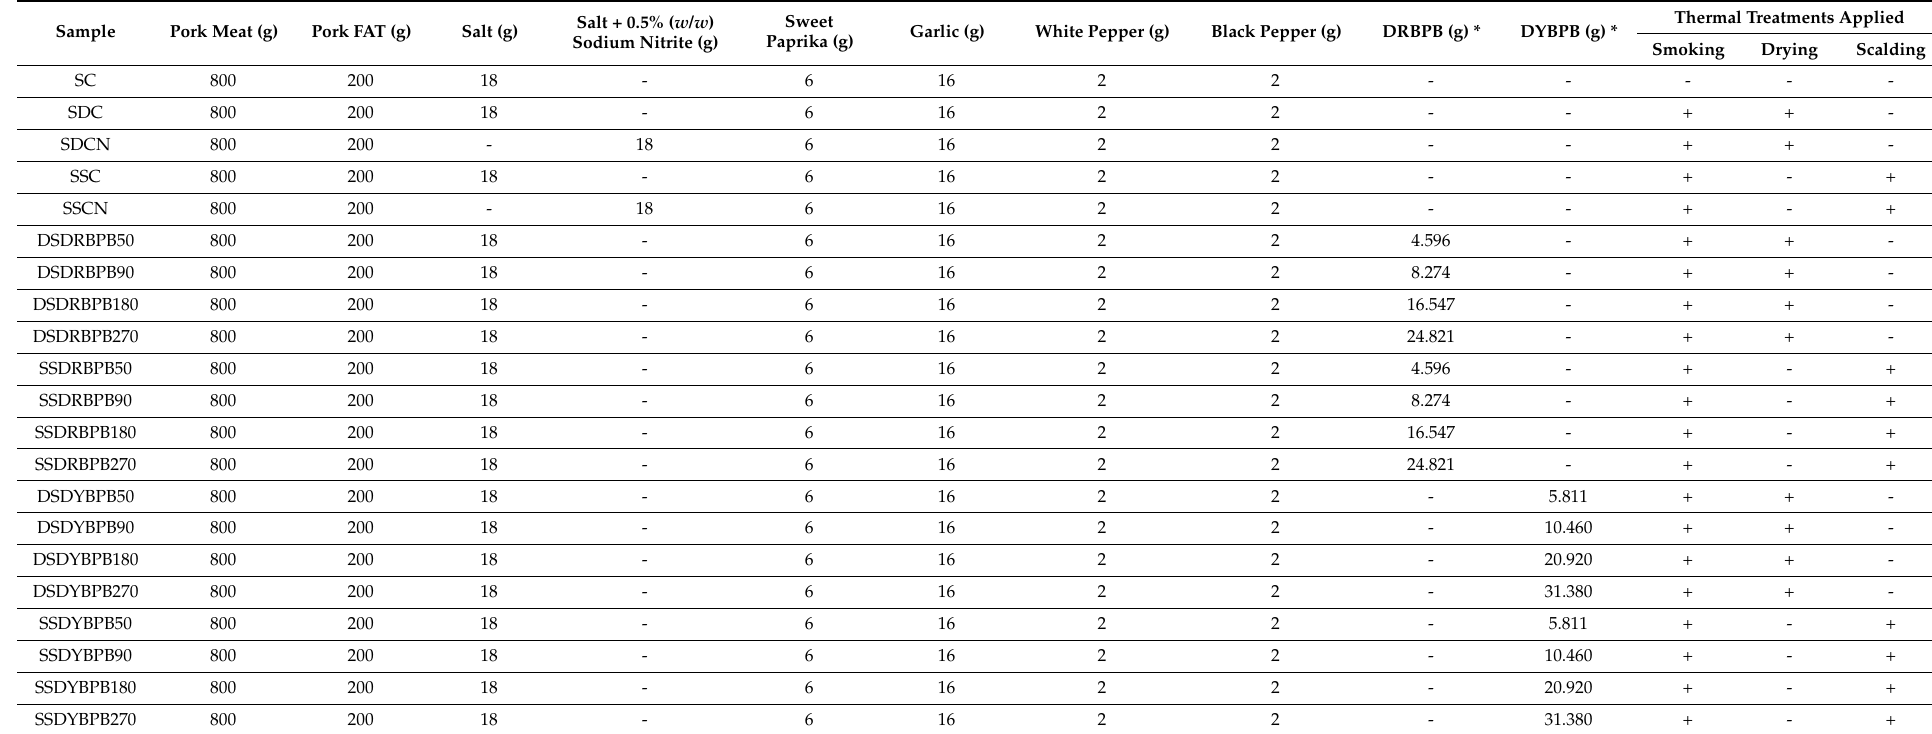
Table 1. The recipes used to obtain sausage